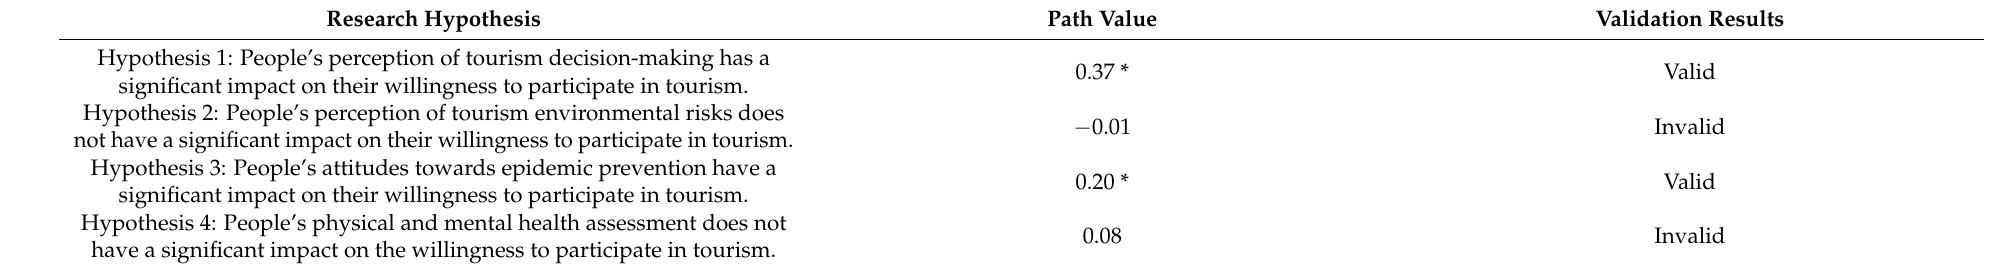
Table 6. Study hypotheses and validation